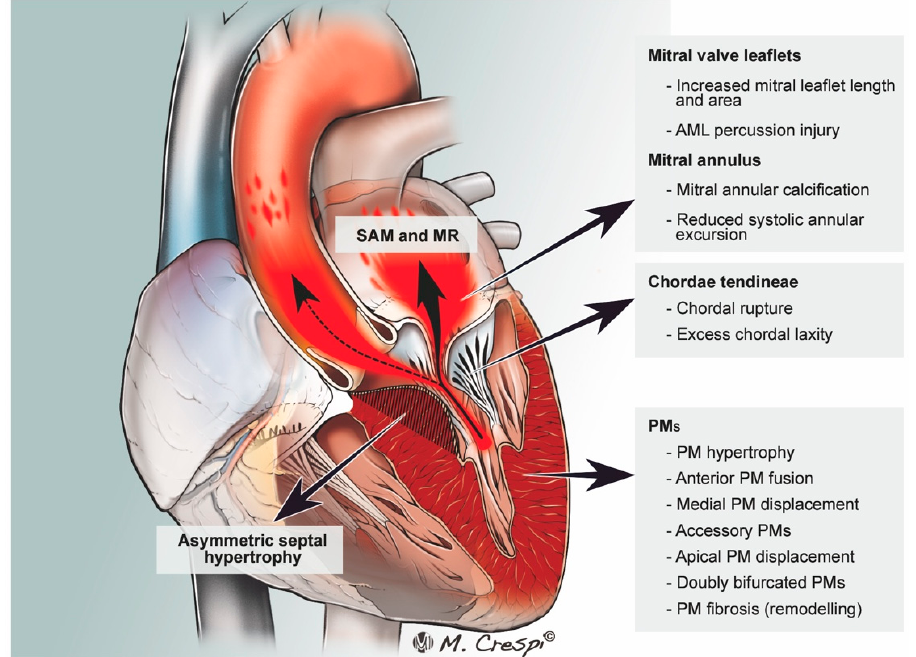
Figure 4. Pathophysiology of left ventricle outflow tract (LVOT) obstruction (dotted arrow) in hy- pertrophic obstructive cardiomyopathy. SAM: systolic anterior motion; MR: mitral regurgitation, MV, mitral valve; AML, anterior mitral leaflet; PM, papillary muscle; APM, anterior papillary mus- cle; MPM, medial papillary muscle. (from Silbiger J.J. et al. J Am Soc Echocardiogr 2016). Surgical approaches to the treatment of the above-stated abnormalities include my- ectomy with concomitant MV replacement (MVR) or repair (MVr) with or without papil- lary muscle repositioning (Figure 5).